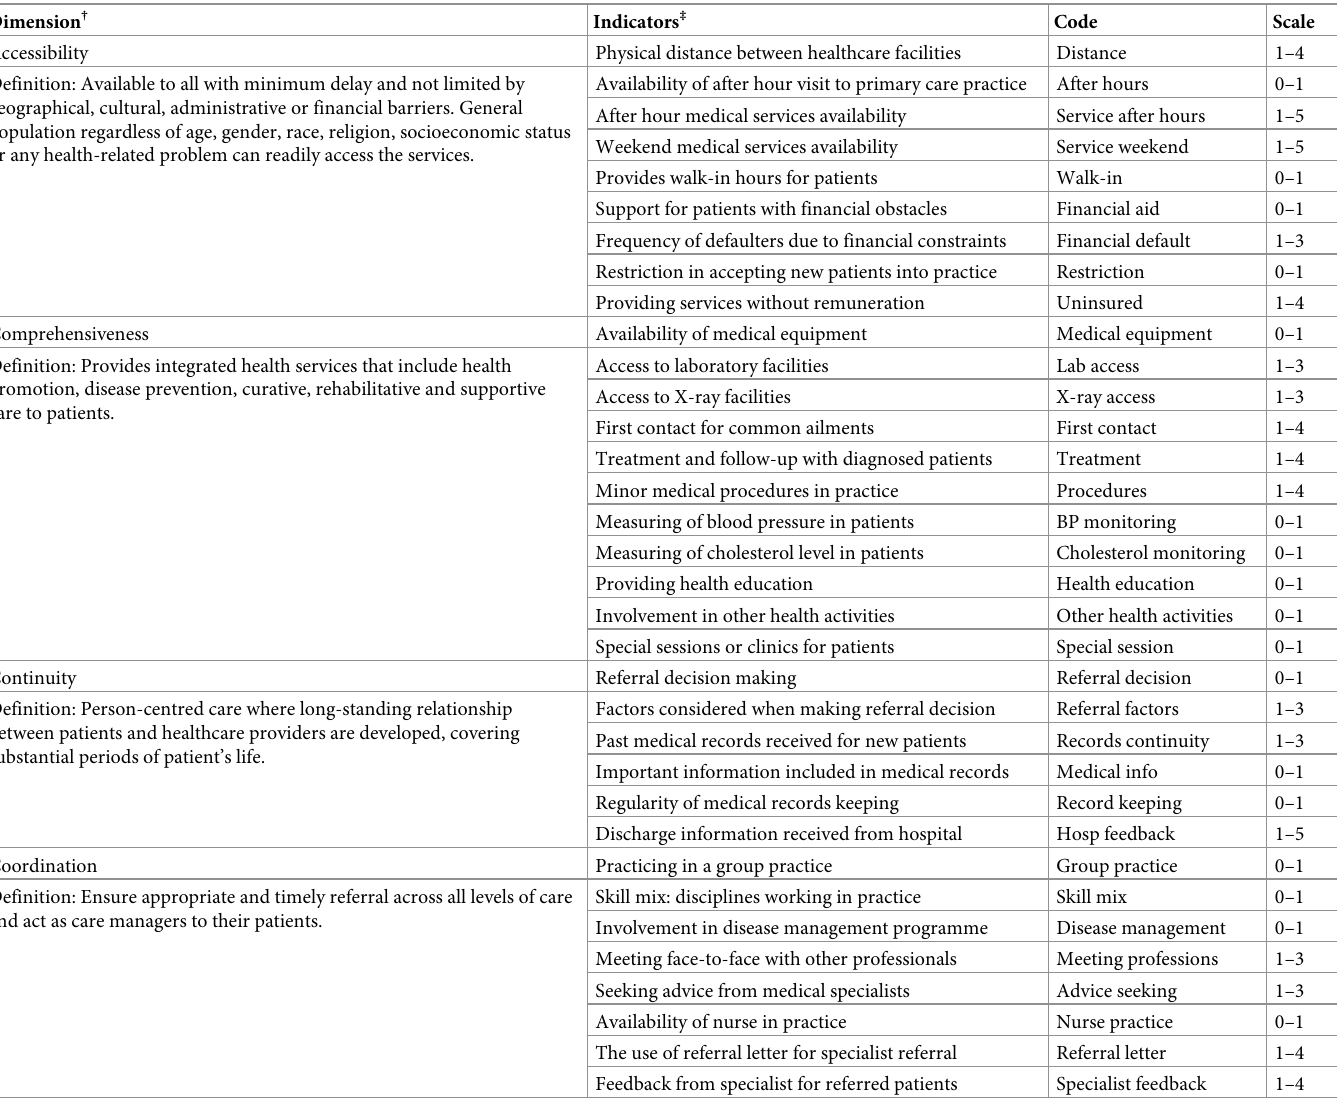
Table 1. List of indicators and its respective